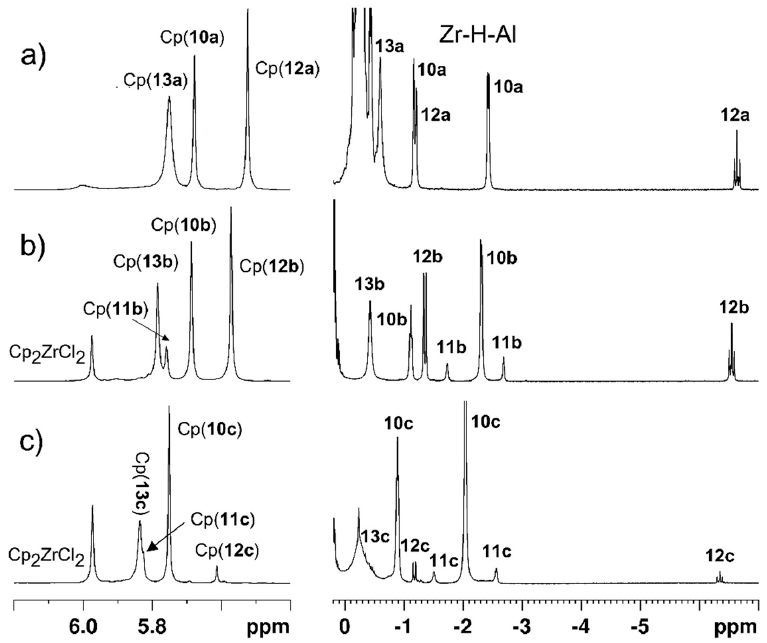
Table 3. 1 H and 13 C NMR of complexes 10a , 12a , 13a , 12 а∙ MAO ( δ , ppm, 400.13 MHz, C 7 D 8 , T = 27 °C).